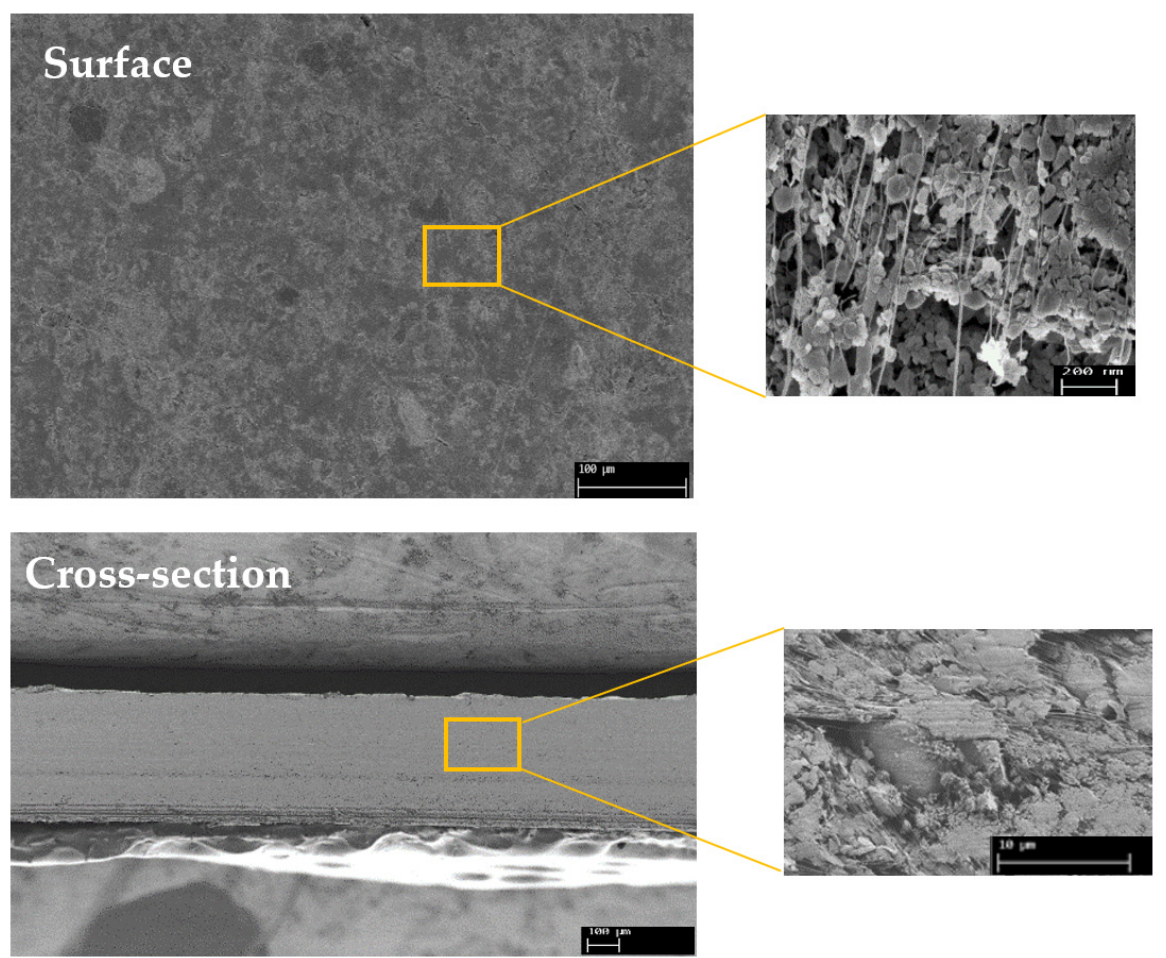
Figure 5 . SEM images of the surface and cross-section of our prepared BN/PTFE membrane. Figure 5. SEM images of the surface and cross-section of our prepared BN/PTFE